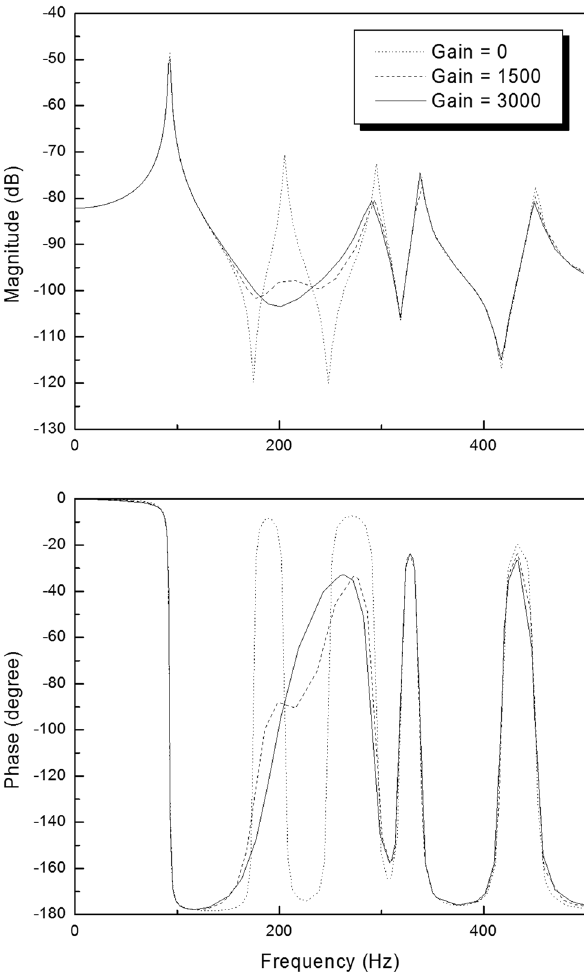
Figure 10: Responses of a sti ff ened plate ( case 1 ) with various control gains: ( a ) vertical displacement, ( b ) transverse bending displacement and ( c ) lateral twisting